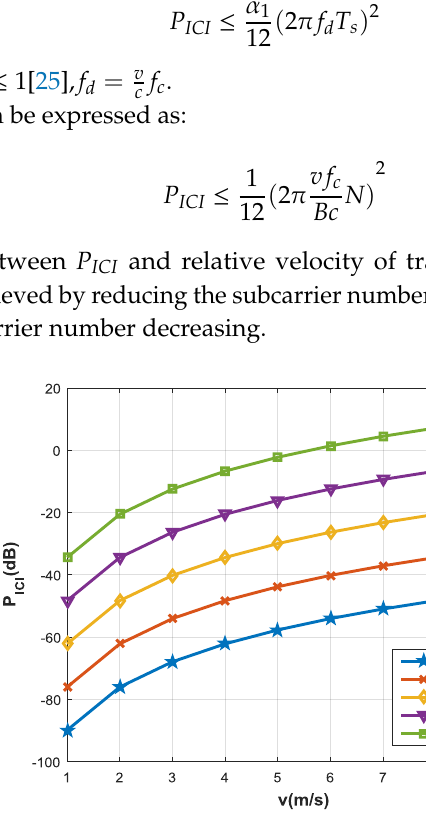
Figure 10. The relationship between ICI